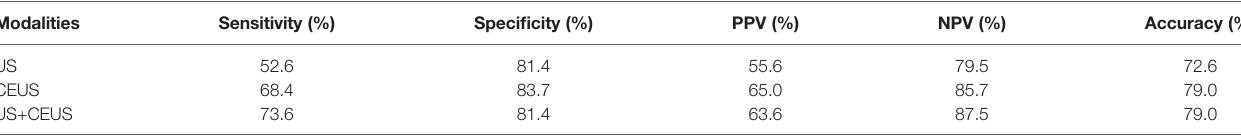
TABLE 2 | Diagnostic performance of US, CEUS, and US combined CEUS for ECE of PTC. Modalities Sensitivity (%) Speci fi city (%)